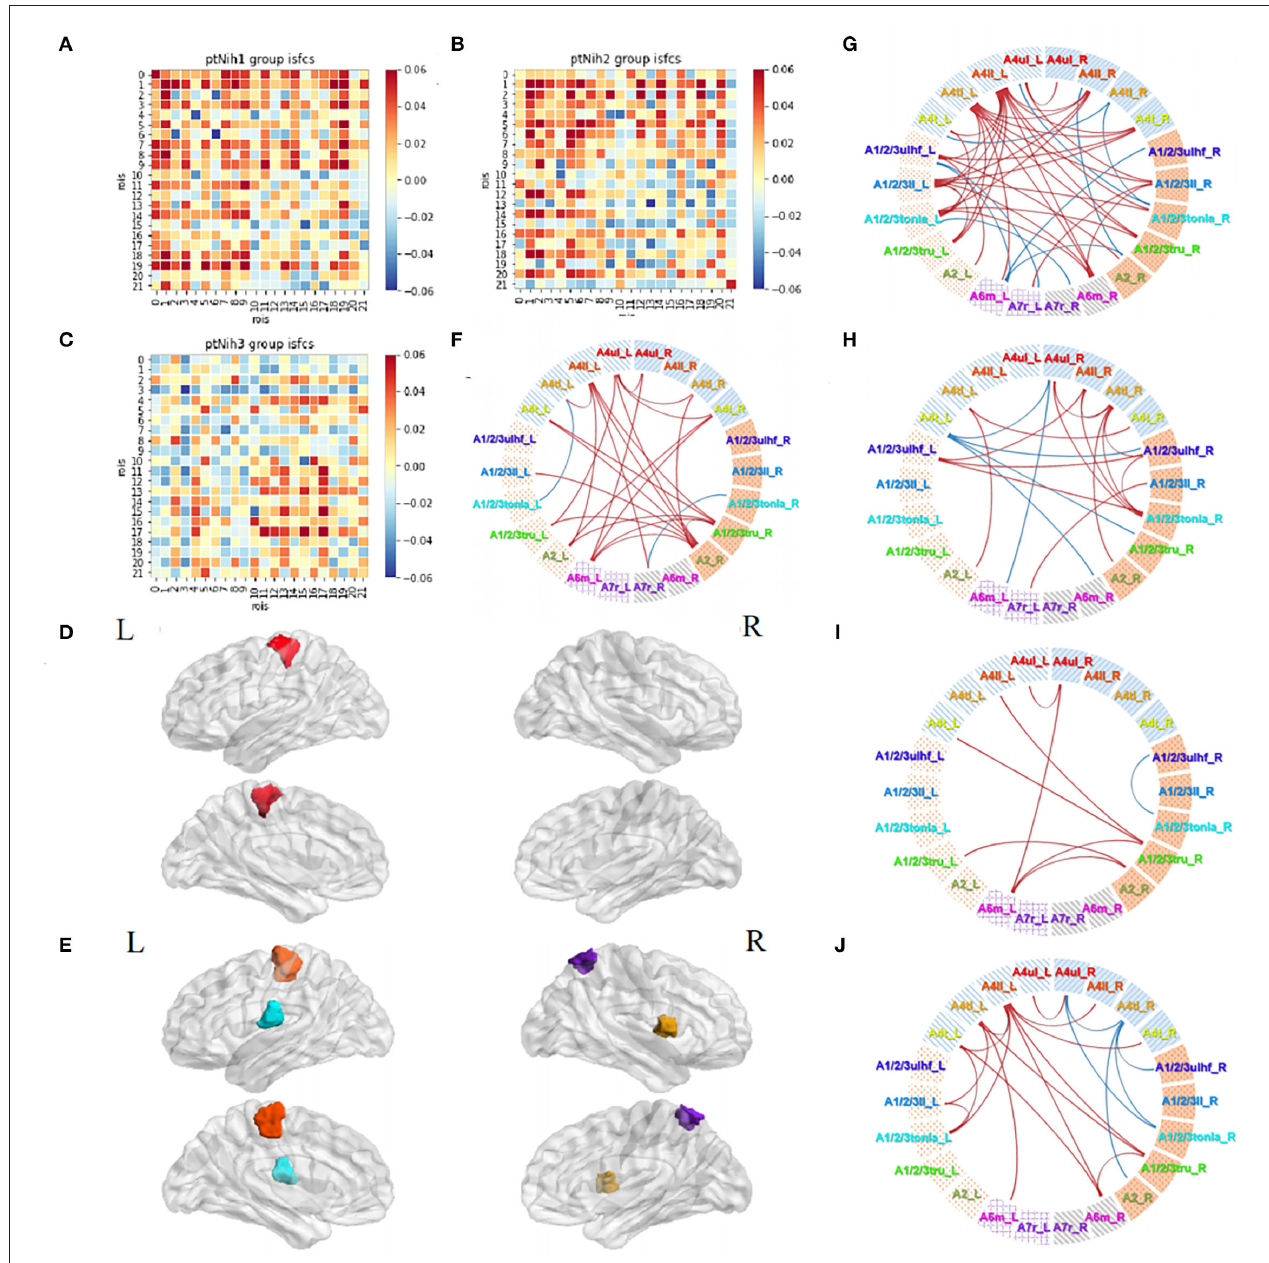
FIGURE 8 | Acupuncture task-stimulated ISC and ISFC in subgroup Nihs. (A–C) ISFC matrix of 22 ROIs in Nih1, Nih2, and Nih3. (D,E) Significantly stimulated ROI in Nih1, Nih2 ( p < 0.05, FDR-corrected). (F–H) Significant ISFCs in Nih1, Nih2, Nih3 group ( p < 0.05, FDR-corrected). (I) Significant ISFCs between Nih1 vs. Nih3 ( p < 0.05, FDR-corrected). (J) Significant ISFCs between Nih2 vs. Nih3 ( p < 0.05,